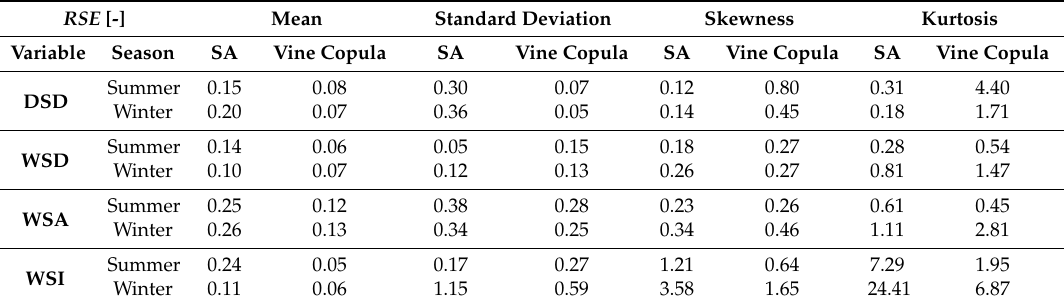
Table 5. Evaluation of statistics of different variables describing the external structure of rainfall events resulting from two models for multisite synthesis based on areal precipitation and presented for all cases as